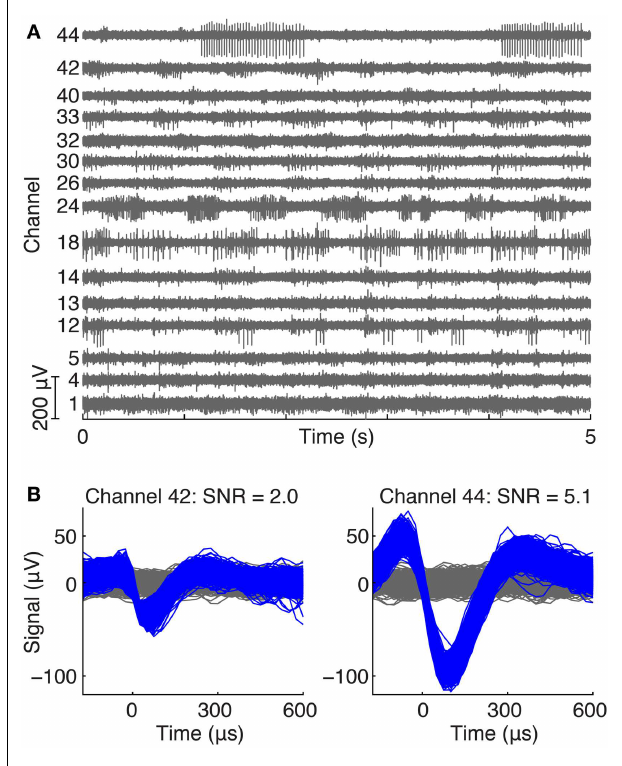
FIGURE 2 | (A) Example of ventral root recordings during an awake trial. Phasically modulated spiking activity occurred on many channels during a treadmill locomotion trial. (B) Typical action potential waveforms recorded from motor axons in the ventral root with their respective